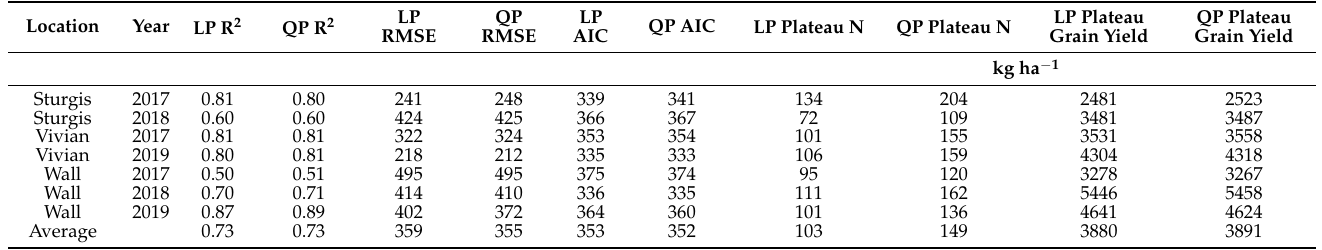
Table 2. Regression statistics for the linear plateau (LP) and quadratic plateau (QP) models and plateau N rate and corresponding grain yield at the hinge point, where R 2 is the coefficient of determination, RMSE is root mean square error, and AIC is Akaike information criterion.